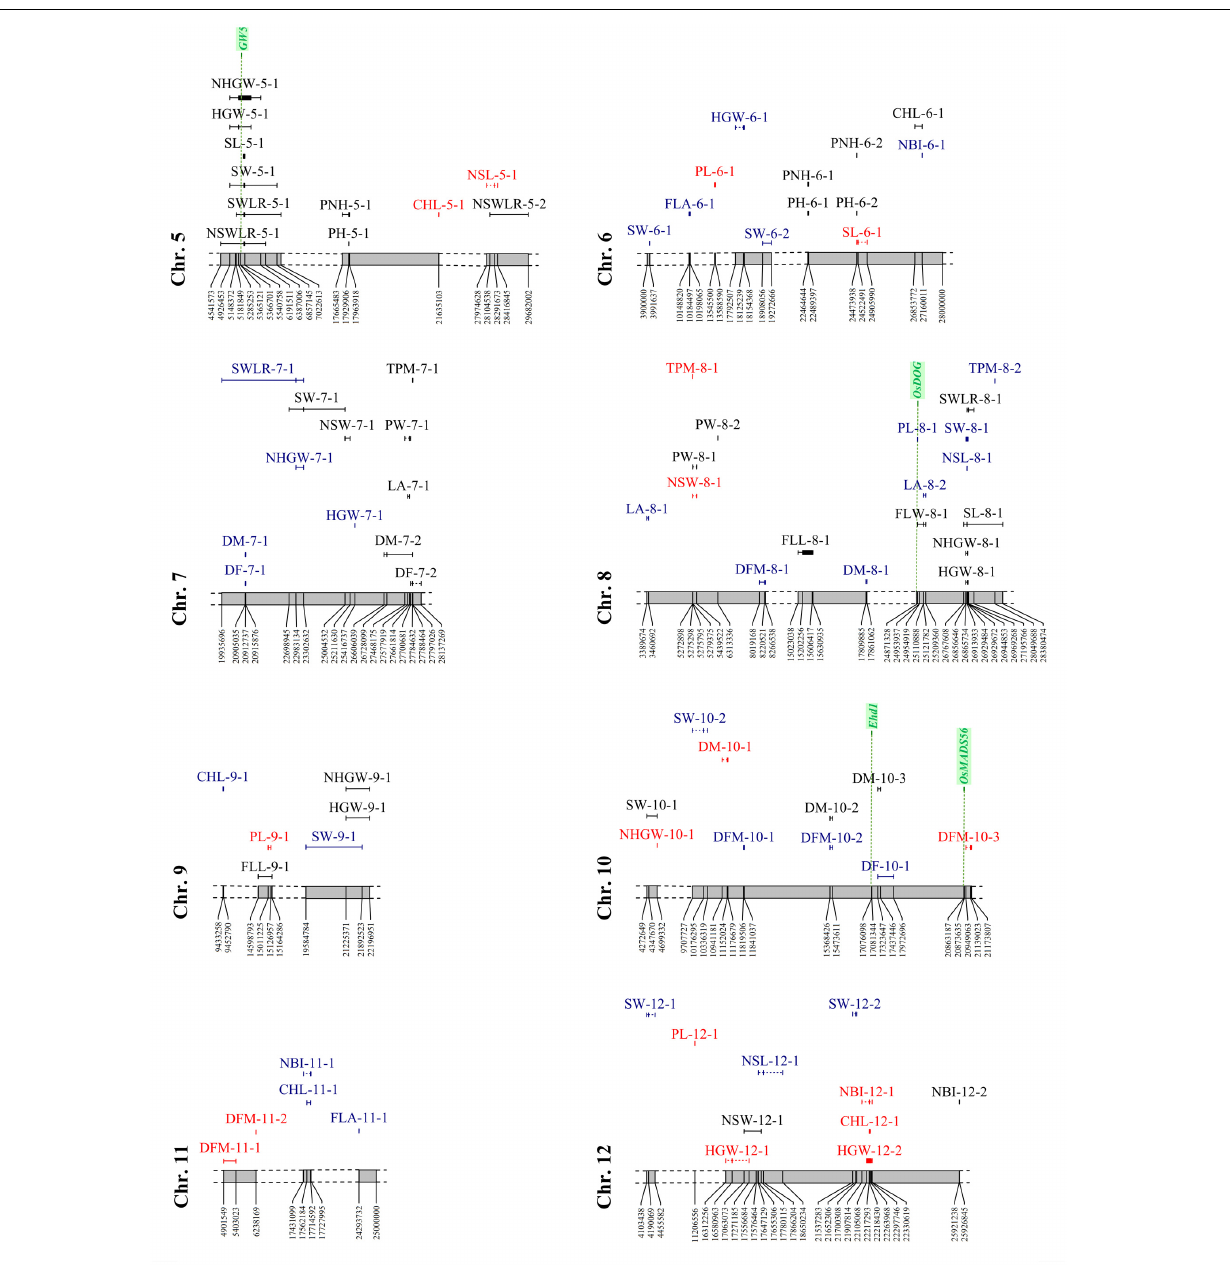
FIGURE 7 | Distribution of the significant associations detected on chromosomes 5 to 12, as indicated in Supplementary Tables S2 and S3 (sheet 1). Acronyms of the traits are as indicated in Table 1 . Associations LW-specific, PF-specific and common to both watering treatments are represented in red, blue, and black, respectively. Candidate gene locations are shown as green vertical dashed lines with names on